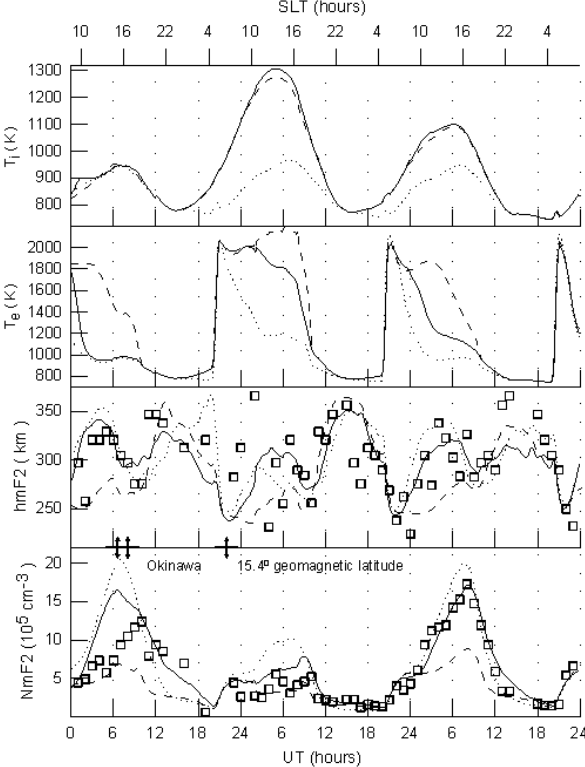
Fig. 6. From bottom to top, observed (squares) and calculated (lines) of NmF 2, hmF 2, electron temperatures and O + ion tem- peratures at the F 2-region main peak altitude above the Manila ionosonde station during 25–27 August 1987. SLT is the solar local time at the Manila ionosonde station. The start times of the sudden commencement (06:58 UT on 25 August), main phase (08:00 UT on 25 August) and recovery phase (22:00 UT on 25 August) of the geomagnetic storm are indicated by the arrows. The curves are the same as in Fig. 4.